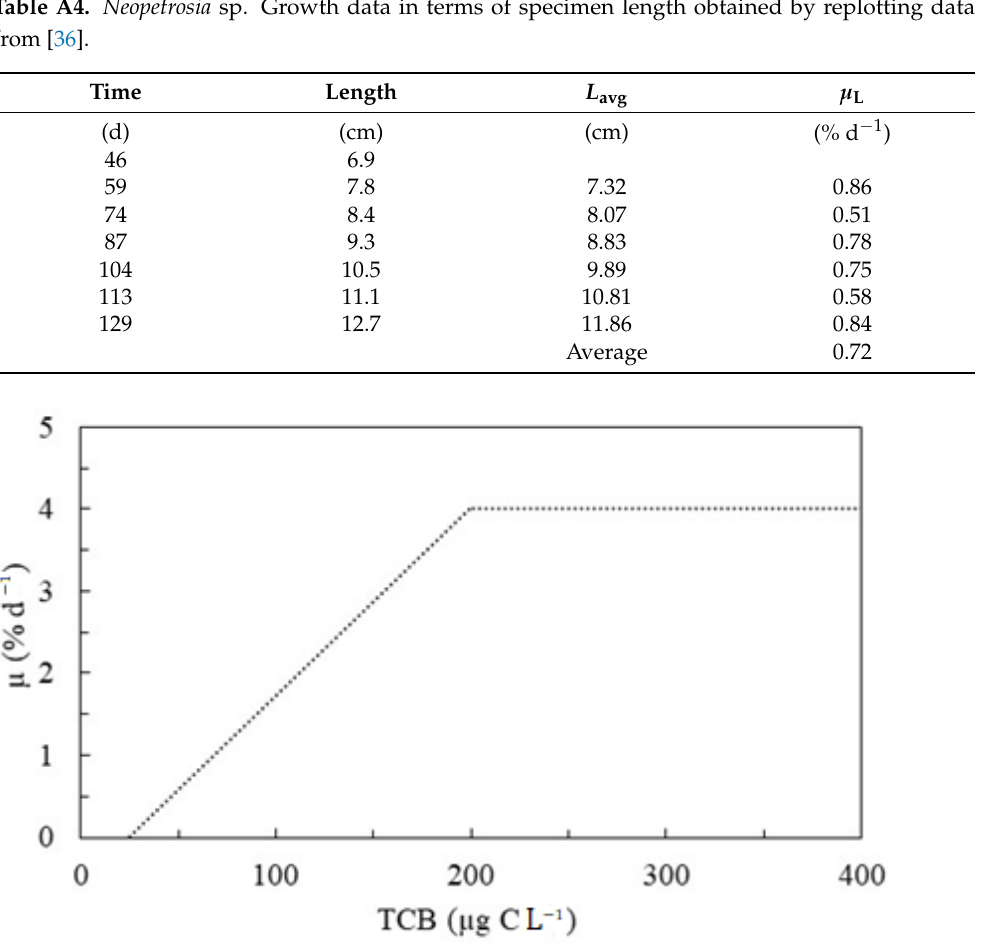
Figure A1. Halichondria panicea . Estimated weight-specific growth rate as a function of TCB (total sponge-available carbon biomass) according to Equation (7) and suggested maximum possible growth rate µ = 4% d − 1 at C max = 200 µ g C L − 1 = 8 × C m (maintenance TCB). The increase in specific growth rate is linear between C m and C max .